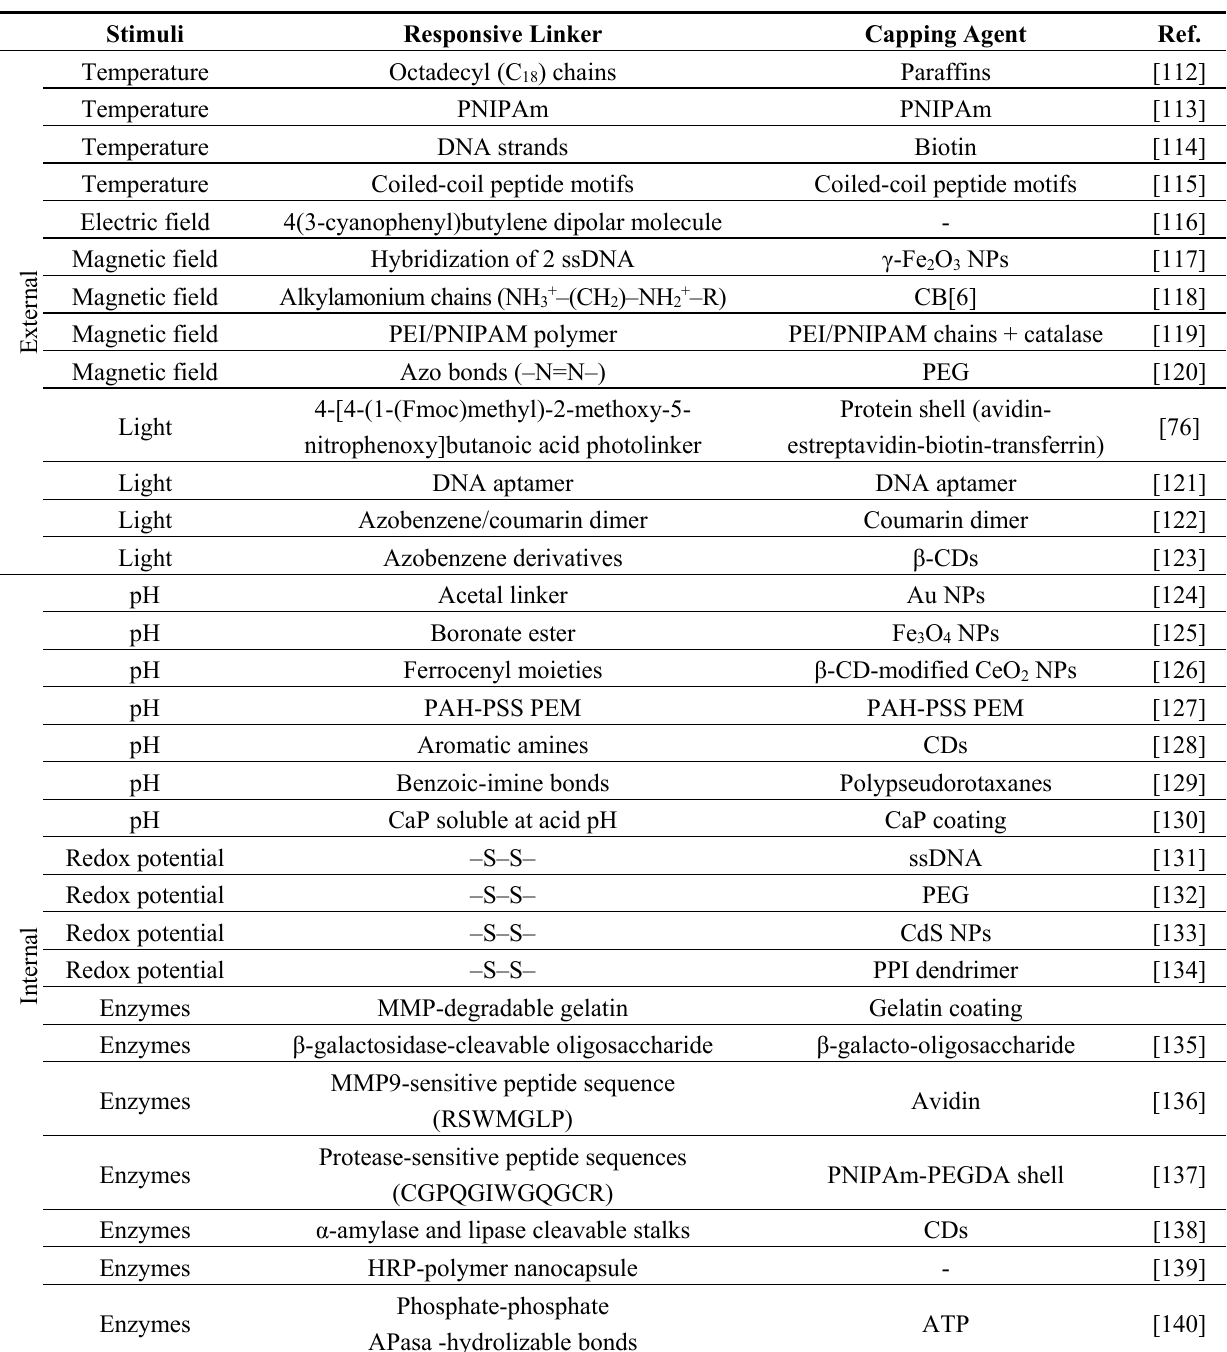
Table 2. Stimuli-responsive strategies for smart drug delivery mesoporous silica